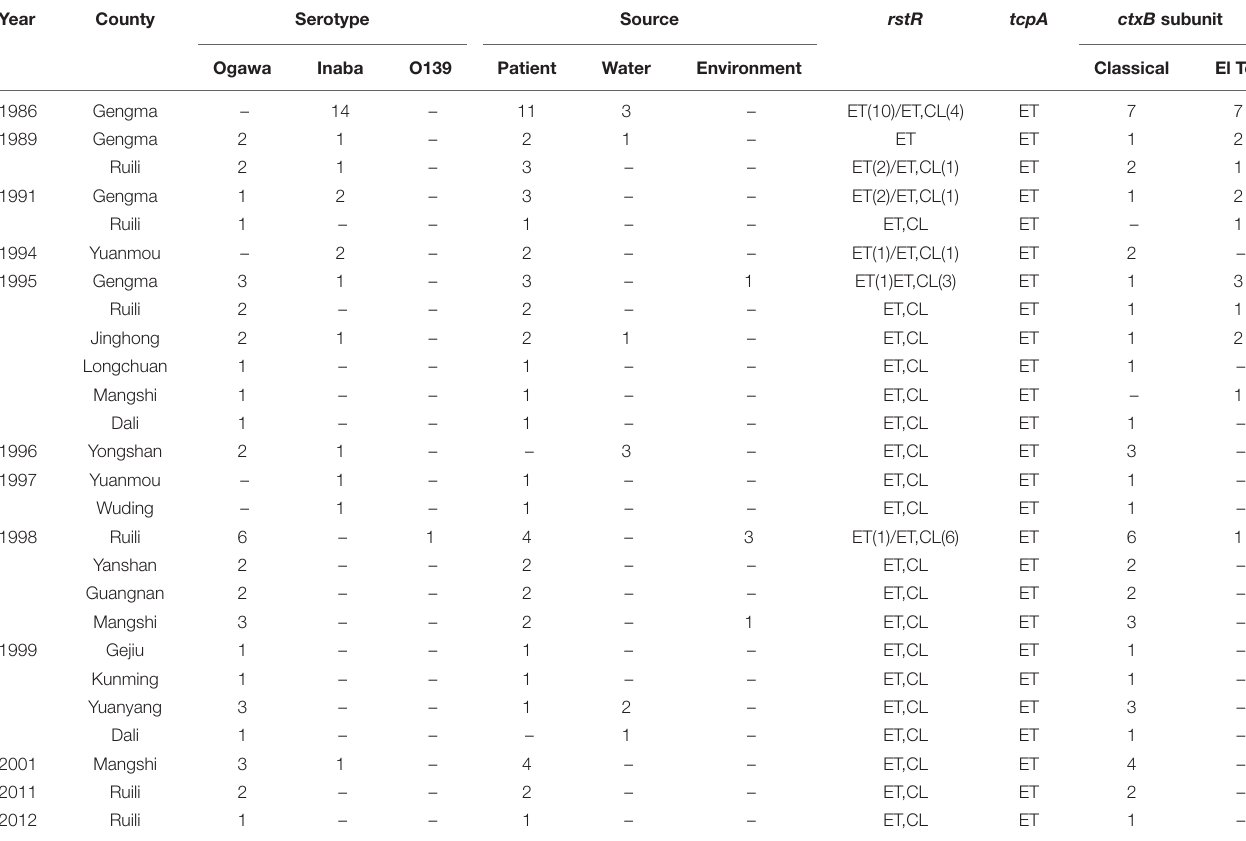
TABLE 1 | The 70 V. cholerae strains used in this